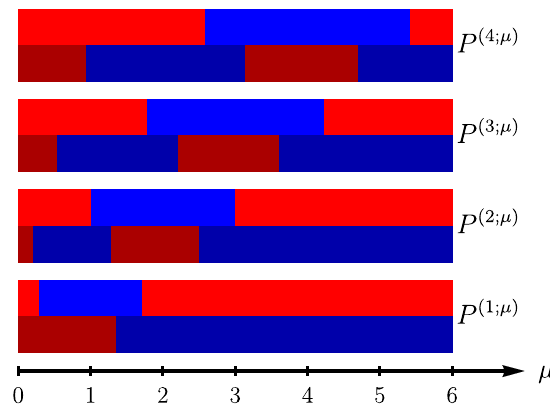
Fig. 3 Nonclassicality of noisy Fock states. Notation is as in Fig. 2. We highlight the regions of nonclassicality detected by K 1 (upper light red) and K 1 ; 2 (lower dark red) for noisy Fock states statistics P ( k ; μ ) , for k = 1, 2, 3, 4. For example, we see that μ = 1.5 corresponds to a classical statistics for P (1; μ ) , a nonclassical one detected by K 1 ; 2 for P (2; μ ) , and a nonclassical one also for P (3; μ ) and P (4; μ ) , now detected by K 1 . Further details can be found in Supplementary Figs. 6 and